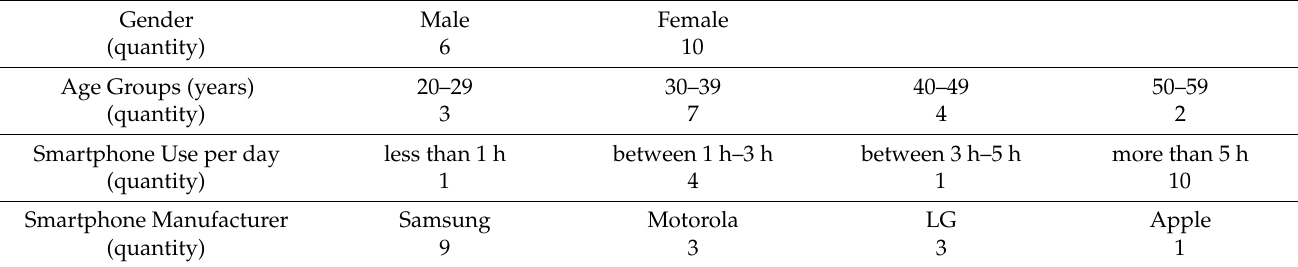
Table 4. Volunteers